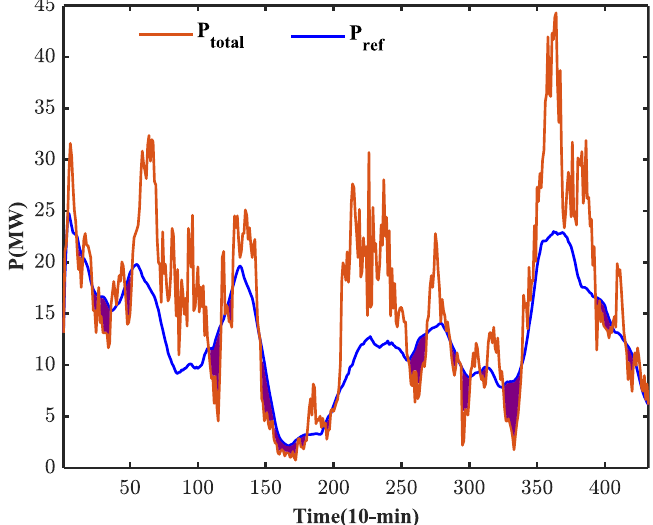
Figure 15. Sample of total output power and smoothed wind power.